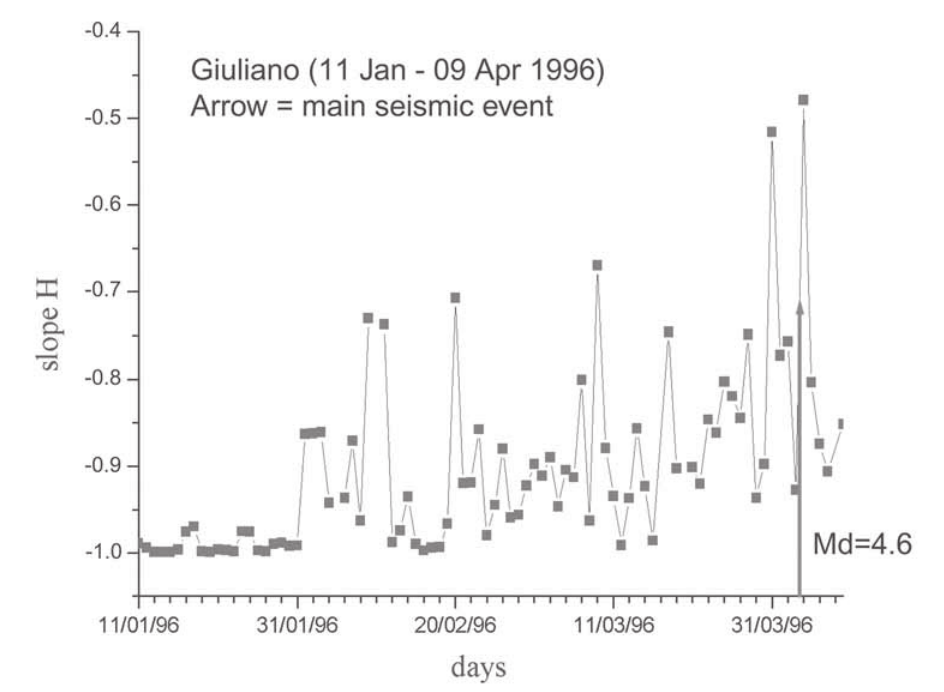
Fig. 4a. Time series of H computed every day during a few months before the occurrence of the earthquake reported in fig. 4b, close to the recording station Giuliano. The system reveals a clear trend from random AE towards a progressively better organised phenomenon, characterised by rupture along some preferred plane, to be iden- tified either with a fault plane, or maybe more likely (see text) with cleavage of some local solid structure. It is a complex system, originally disordered, which evolves toward an increasing order, until its mechanical structure